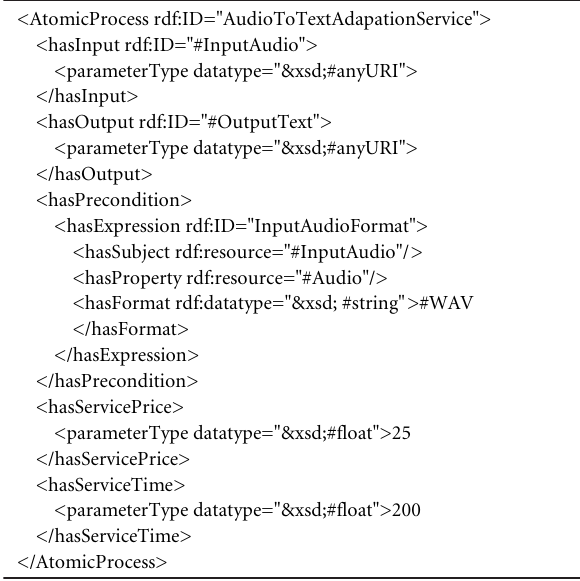
Figure 4: An expert of service description for Audio to Text adap- tation